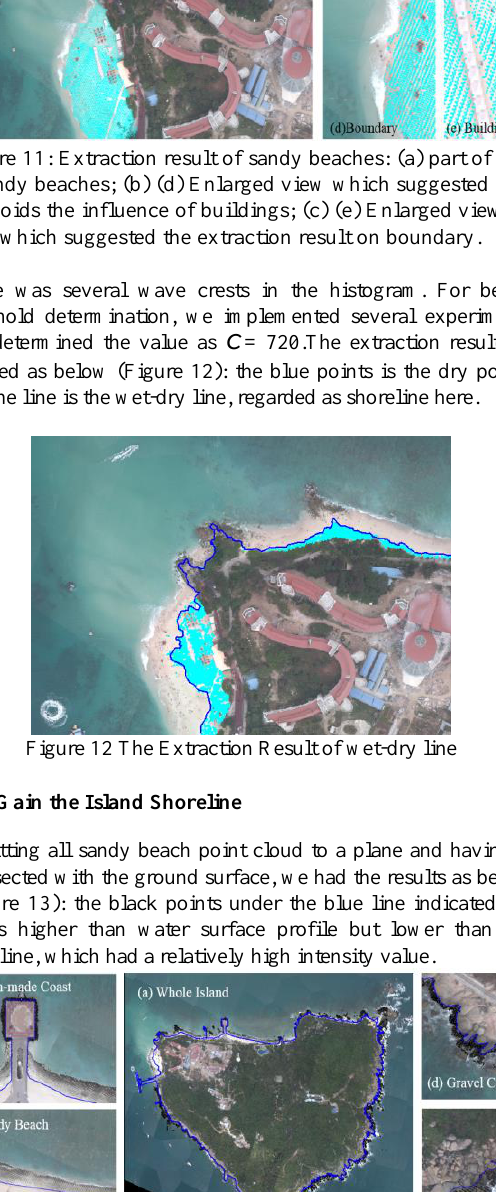
Figure 13: Extraction result of island shoreline: (a) Shoreline of the whole island; (b) Enlarged view which shows the Man-made Coast Shoreline; (c) Enlarged view which shows the sandy beach Shoreline; (d) Enlarged view which shows the gravel coast Shoreline (big rocks); (e)Enlarged view which shows the gravel coast Shoreline (small rocks) The length of the whole shoreline in this region is about